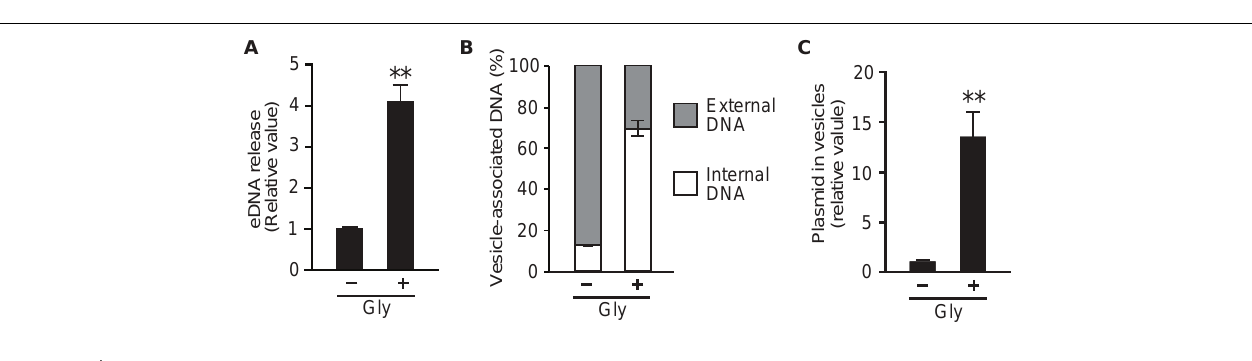
FIGURE 4 | Glycine induces the incorporation of plasmid into vesicles. (A) The production of extracellular DNA (eDNA) in E. coli BW25113 in the absence (-Gly) and presence (+ Gly) of 1% glycine. DNA concentration in the supernatant was normalized to cell densities, and values relative to that of control are presented. (B) Percentage of external and internal DNA of vesicles from E. coli BW25113. Vesicles were treated with or without DNase I, and the DNA concentration was measured using PicoGreen. (C) The ratio of plasmid to DNase I-treated vesicles. The amount of plasmid and vesicles were measured by real-time PCR and nano-tracking analysis, respectively, and the values (plasmid/vesicle) relative to control (-Gly) are provided. In all figures, the data are presented as the mean ± standard deviation from three replicates. * *P < 0.005 compared to the